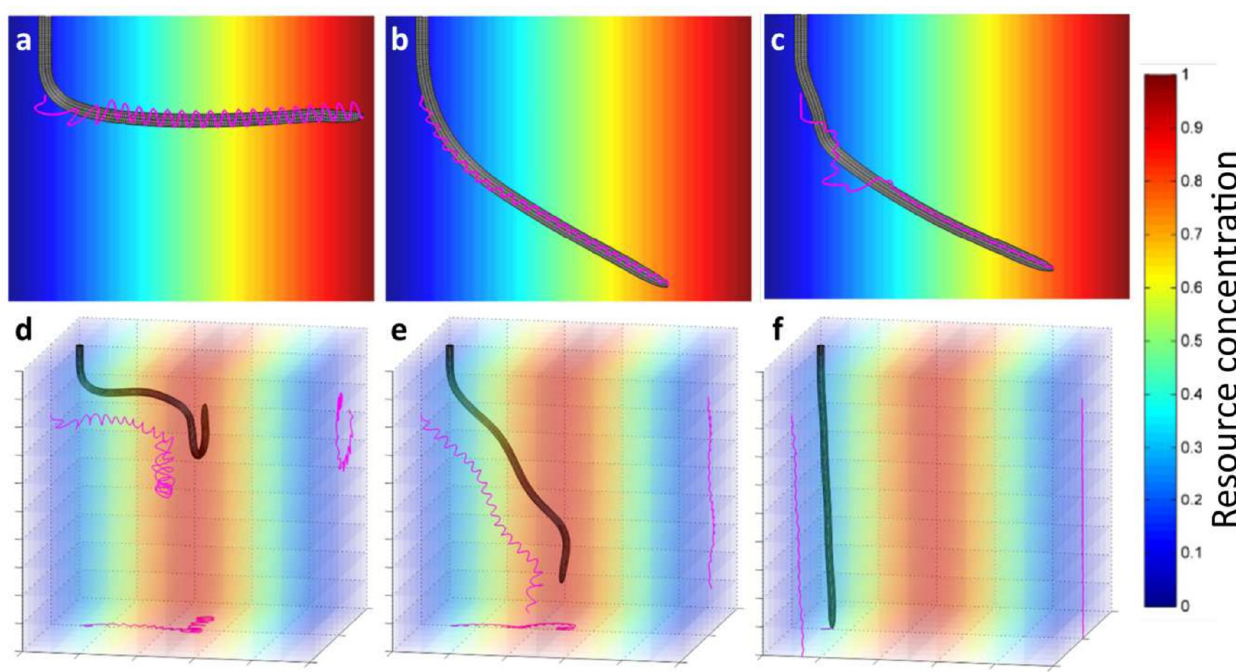
Fig 6. Roots navigate towards regions with higher resource concentration with circumnutation movements driven by an internal oscillatory apparatus. The resource concentration ranges from 0 (blue color) and 1 (red color). In the rows are shown the roots navigation (a, b, c) in the presence of only the resource signal active ( w = w = 0, w 6¼ 0) and (d, e, f) as a result of the interplay between gravity and resource stimulus responses ( w g t s w s 6¼ 0). (a) A sample of navigation with root settings w s = 1, v s = 5D/hour, T s = 0.75 π , d = 3.0 D . (b) The path for a root with settings w s = 0.25, v s = 10D/hour, T s = 0.94 π , d = 2.0 D . (c) A sample of a non-regular pattern of circumnutation movements obtained with root settings w s = 0.75, v s = 2.5 D/hour, T s = 1.07 π , d = 4.5 D . For simulations in (d, e, f), stimulus and gravity signals originate at the tip and propagate along the root with speed v s = v g = 5D/hour. The internal oscillator outputs s = 1 at d = 0 and ϕ which changes over time with frequency T = π . Weights of resources and gravity for each root were: (d) w s s 0.1; (e) w s = 0.6, w g = 0.4; (f) w s = 0.1, w g = 0.9.